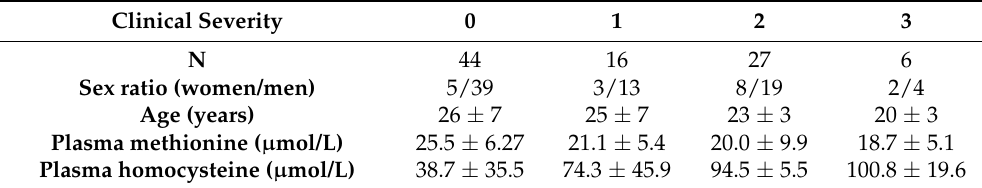
Table 1. Characteristics of patients according to clinical severity. Groups are based on the severity of their clinical symptoms based on Peripheral Neuropathy Disability (PND) score: level 0: no symptoms, level 1: patients with distal sensory disorders without gait disorders, level 2: patients with walking disorders, but they can walk without help, and level 3: patients with walking disorders who need help or bedridden patients. Data are expressed as mean ±